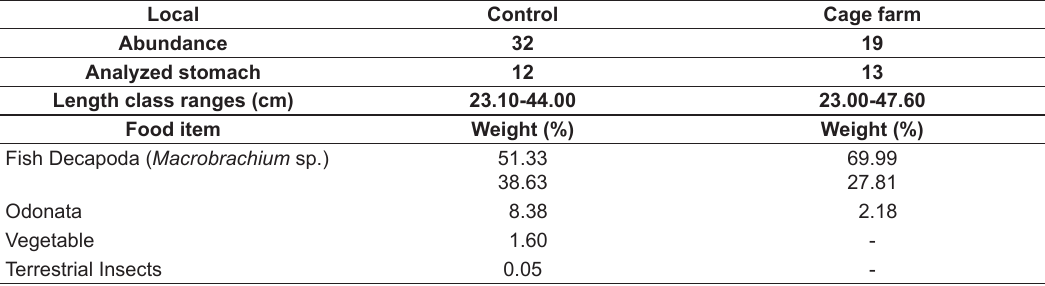
Table 1. Food items consumed by Rhaphiodon vulpinus in the Ilha Solteira Reservoir, Upper Paraná River basin, Brazil. Values are based on percentages of the weight of food items.